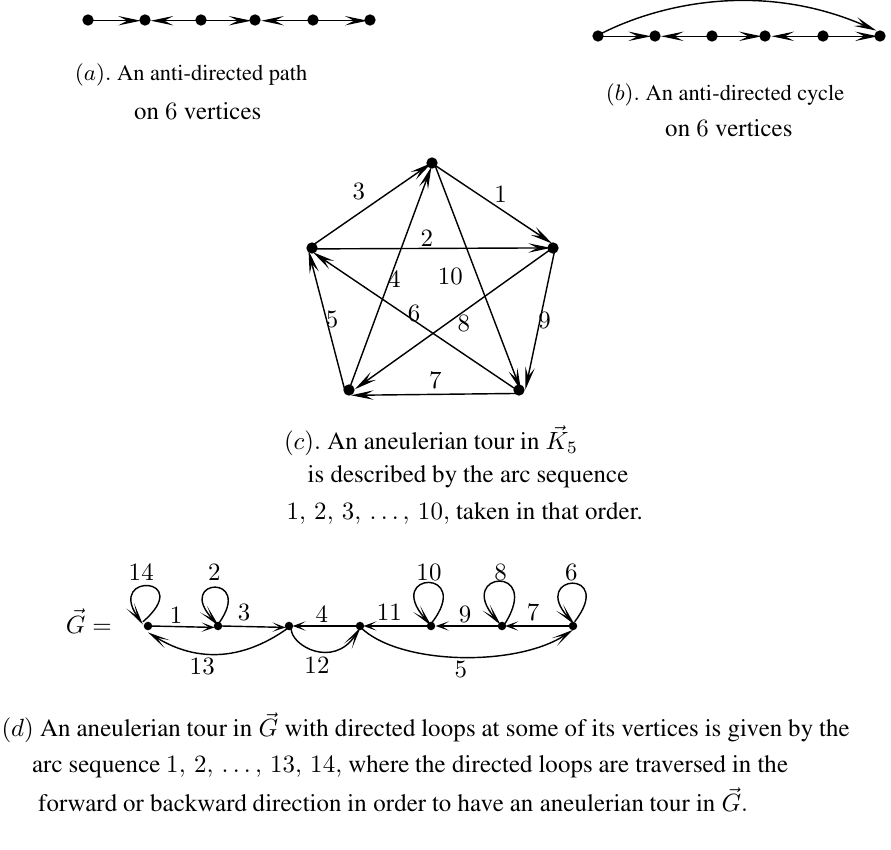
Fig. 1: Examples for anti-directed path, anti-directed cycle and aneulerian